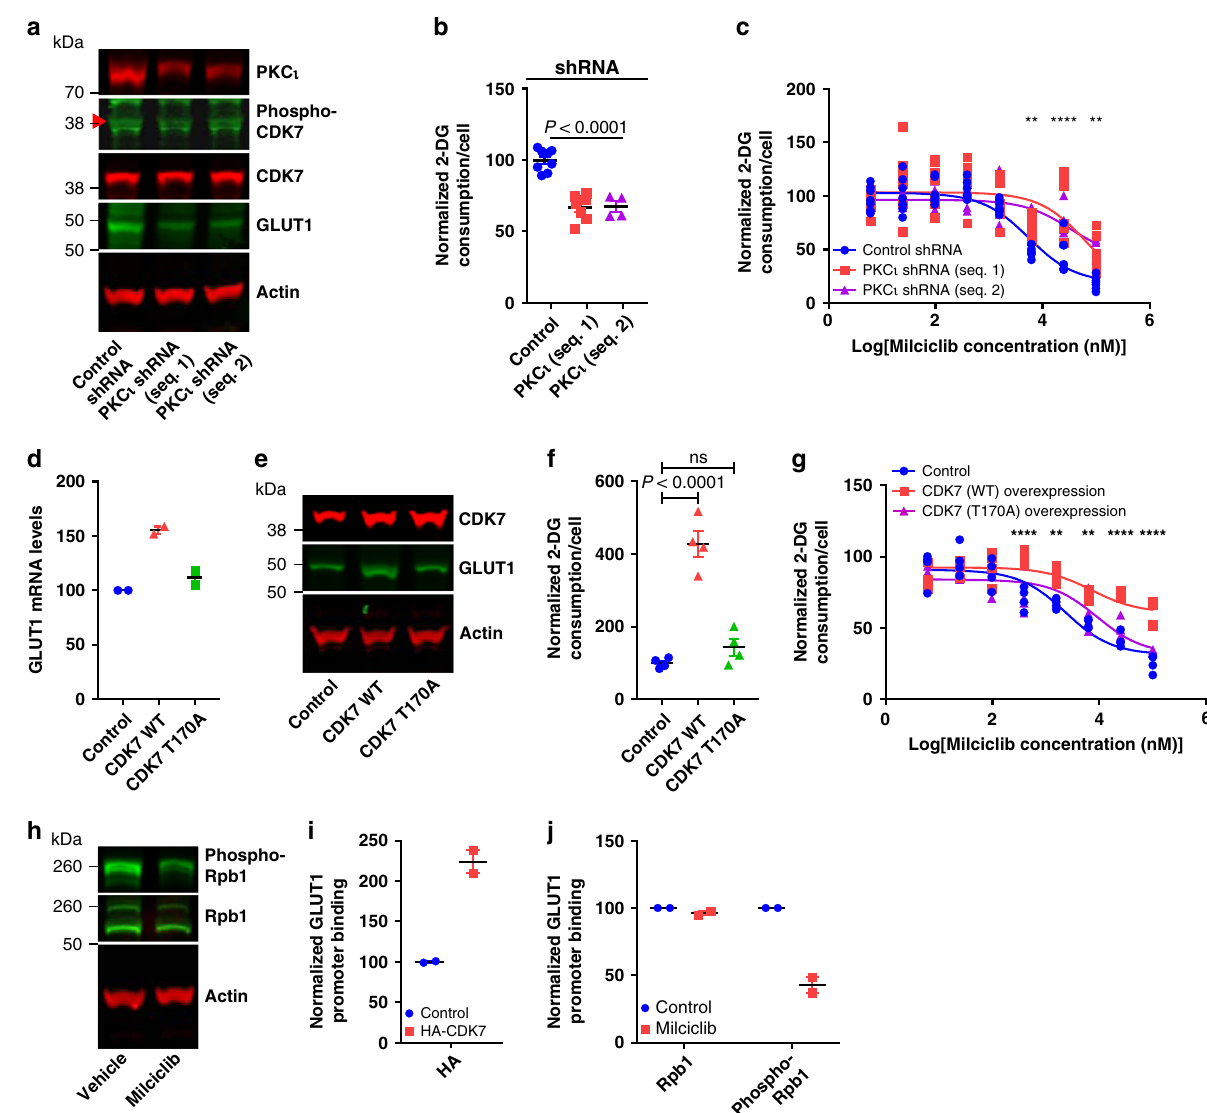
Fig. 7 PKC ι activates CDK7 to promote glucose consumption. a Immunoblots from H460 cells transfected with control shRNA or shRNA targeted against PKC ι . Seq. 1 and 2 represent different shRNA sequences. n = 2. b Glucose consumption in H460 cells transfected with control shRNA or shRNA targeted against PKC ι . Control: n = 8; Seq. 1: n = 7; Seq. 2: n = 4. P value determined by a one-way ANOVA test. c Glucose consumption dose response curves in H460 cells transfected with control shRNA or shRNA targeted against PKC ι and treated with Milciclib. Control: n = 8; Seq. 1: n = 7; Seq. 2: n = 4. P values determined by a two-way ANOVA test. d GLUT1 mRNA levels from H460 cells transfected with a control, wild-type (WT) CDK7, or T170A mutant CDK7 overexpression plasmid. n = 2. e Immunoblots from H460 cells transfected with a control, WT CDK7, or T170A mutant CDK7 overexpression plasmid. n = 2. f Glucose consumption in H460 cells transfected with a control, WT CDK7, or T170A mutant CDK7 overexpression plasmid. n = 4. P values determined by a one-way ANOVA test. g Glucose consumption dose response curves in H460 cells transfected with a control, WT CDK7, or T170A mutant CDK7 overexpression plasmid and treated with Milciclib. n = 4. P values determined by a two-way ANOVA test. h Immunoblots from H460 cells treated with vehicle or Milciclib (10 μ M). n = 2. i HA-CDK7 levels on the GLUT1 promoter in H460 cells transfected with a control or HA-CDK7 overexpression plasmid. n = 2. j Rpb1 and phospho-Rpb1 levels on the GLUT1 promoter in H460 cells treated with vehicle or Milciclib (10 μ M). n = 2. ns: not signi fi cant. ** P < 0.01; **** P < 0.0001. Data are plotted as mean ±